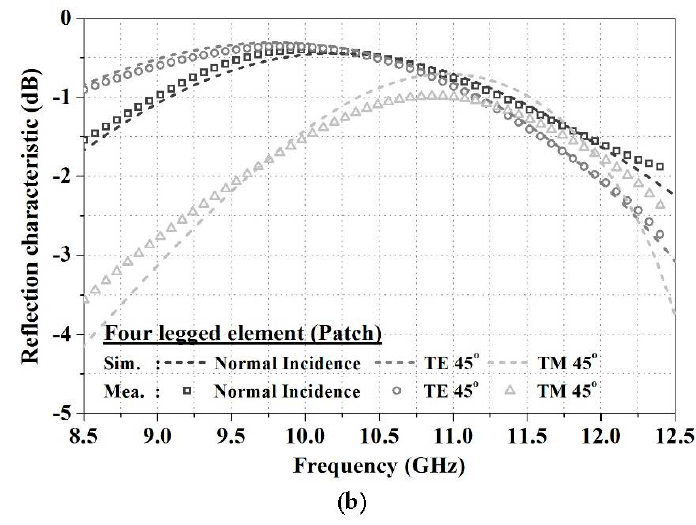
Figure 6. Measurement results of frequency reflection characteristic: ( a ) Loop type; ( b ) Patch type.